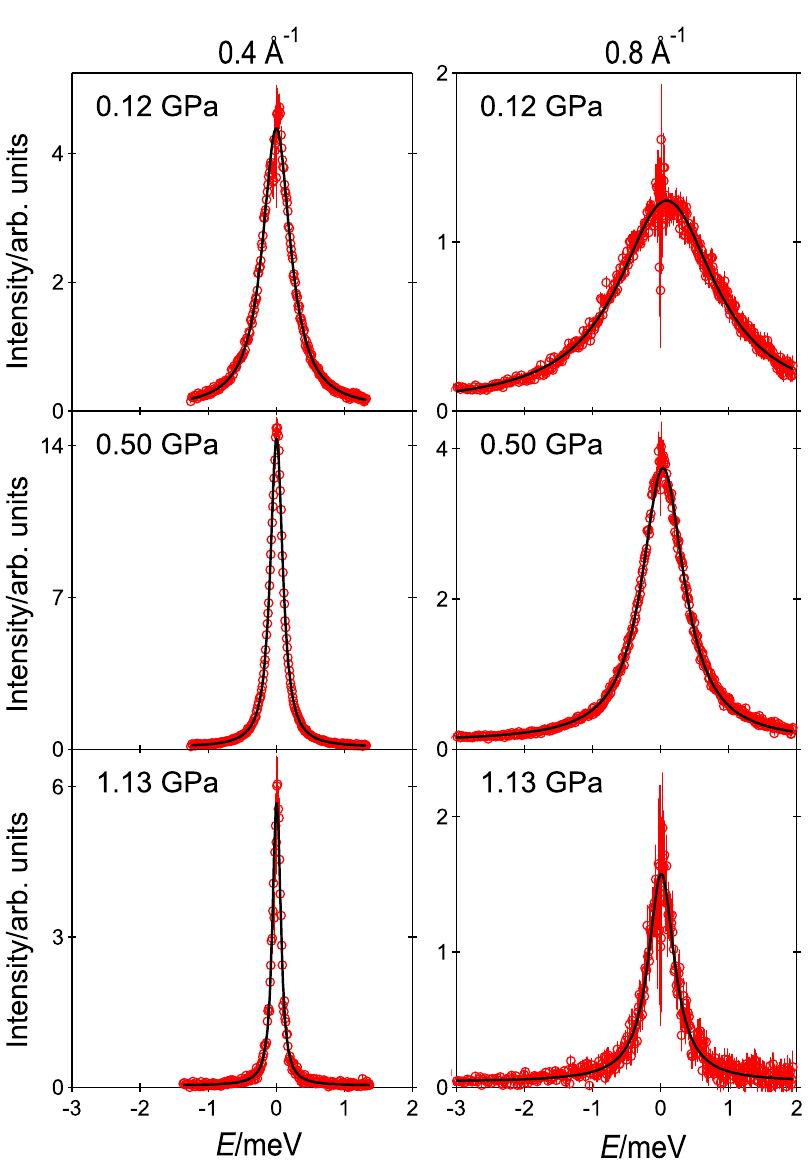
Fig. 1 Examples of measured spectra. QENS spectra of methane at 300 K and the indicated pressure and wavevector transfer values. Experimental data (empty circles) are compared to the resolution-corrected best Lorentzian fi ts (solid lines). Error bars were calculated by the square root of absolute neutron count combined with the law of propagation of